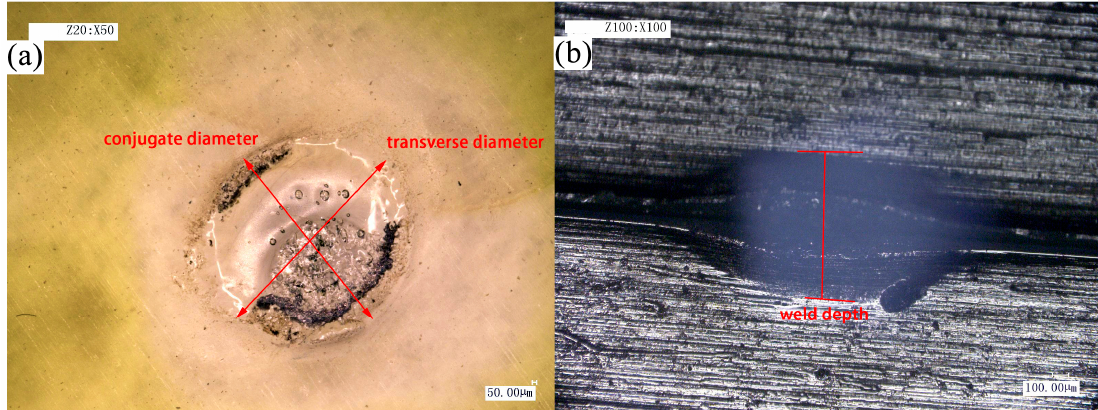
Figure 7. Morphology of weld pool ( a ) weld diameter; ( b ) weld depth.